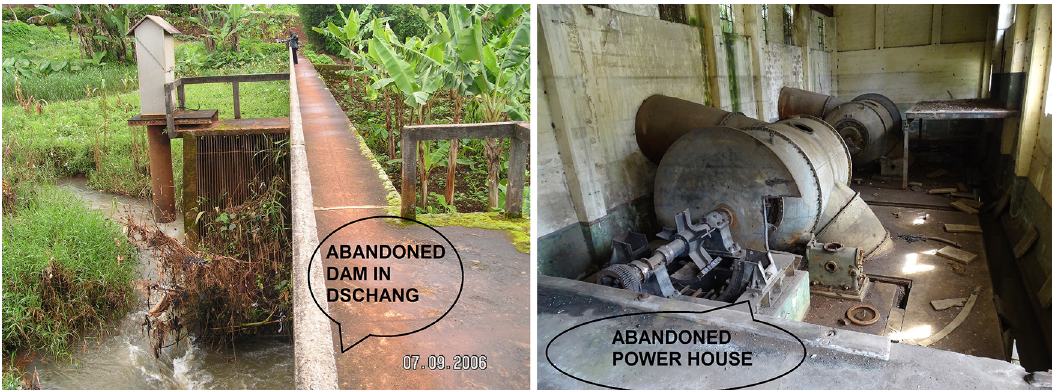
Fig. 12. Abandoned 200 kW in Dschang and 1000kW in Malale (cid:1) Cameroon (Photo J. Kenfack).